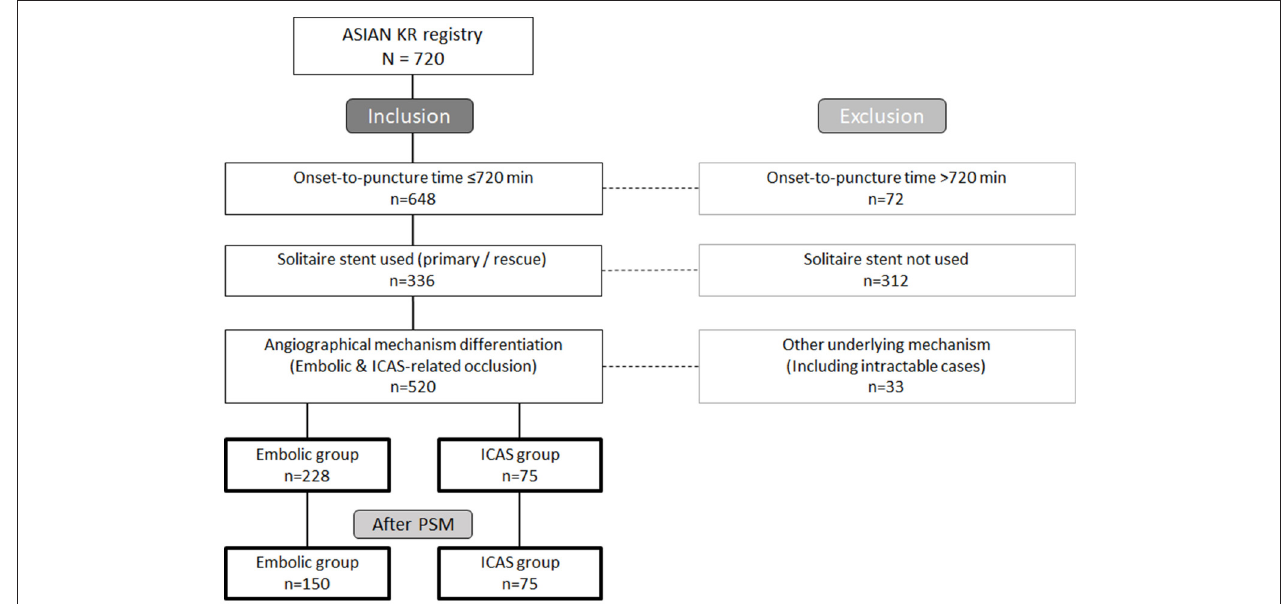
FIGURE 1 | Flowchart illustrating the current study. PSM, propensity score matching.